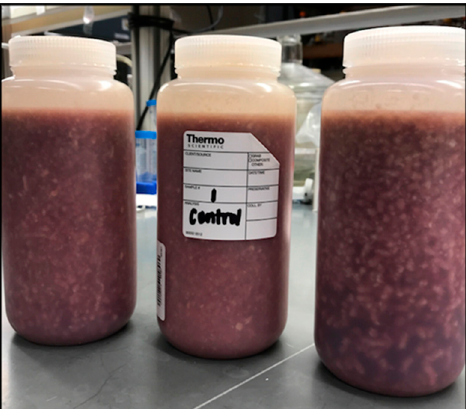
Figure 5. Ground beef enrichment and phage enrichment during shipping. In the examples shown, 650 mL mTSB and 325 g ground beef were added to Nalgene bottles with 1.73 × 10 3 pfu/mL Φ V10 nluc (final concentration) for simultaneous enrichment and detection.